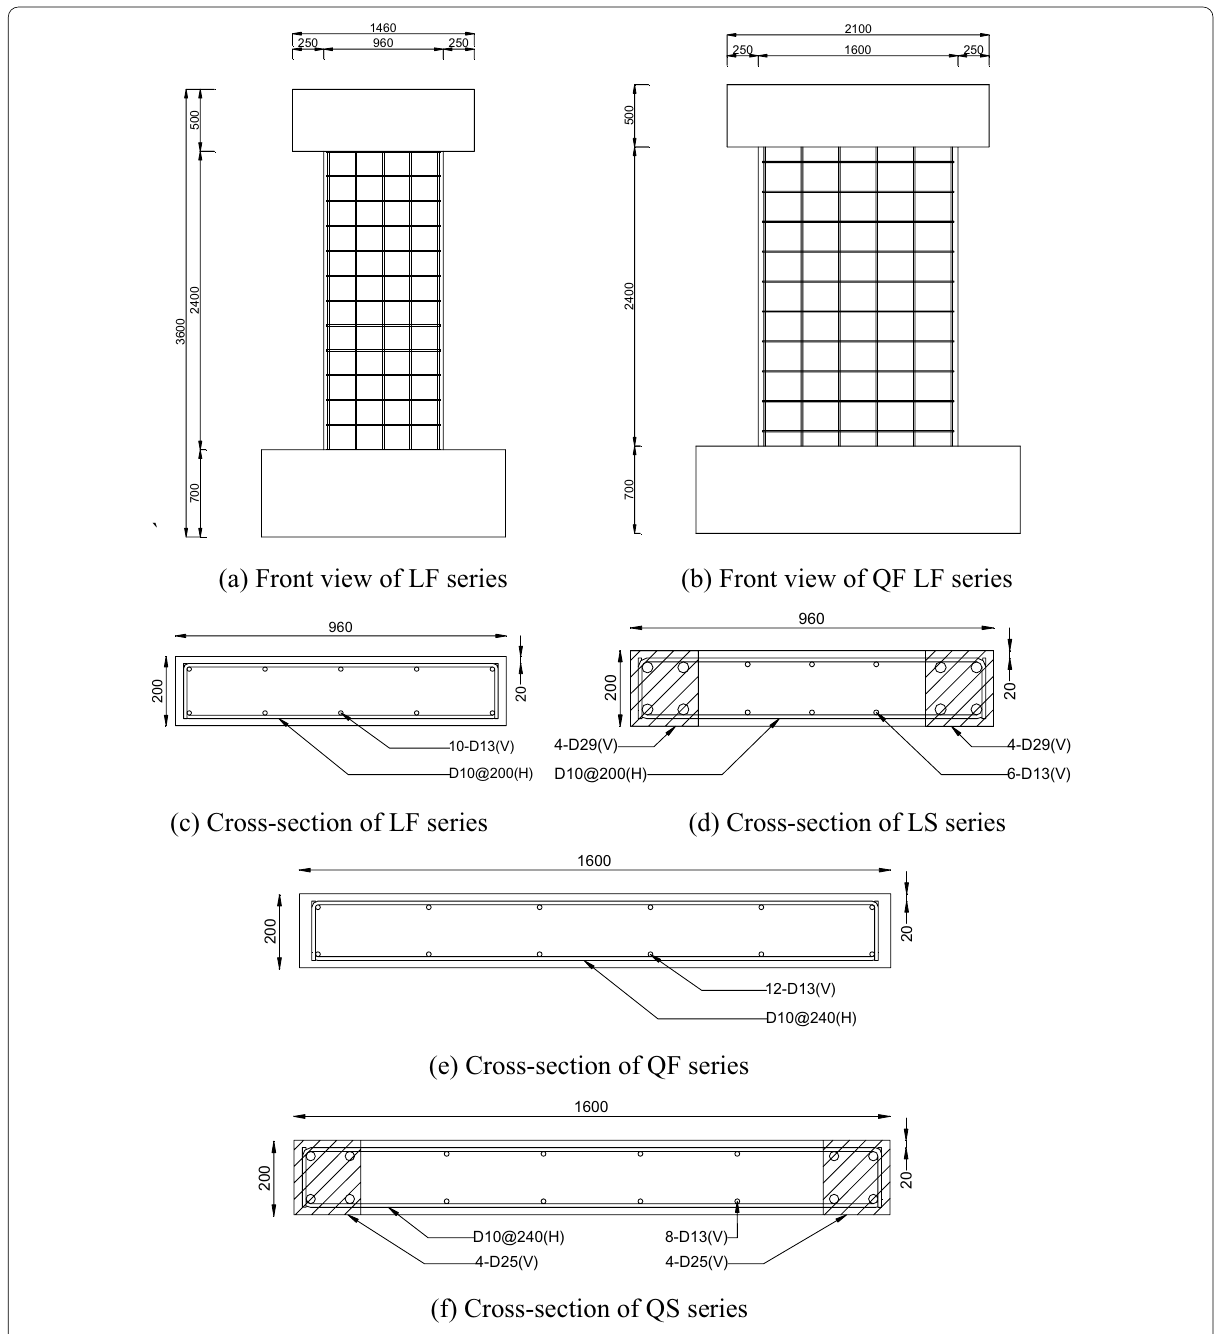
Fig. 1 Geometry and details of specimens (Unit: